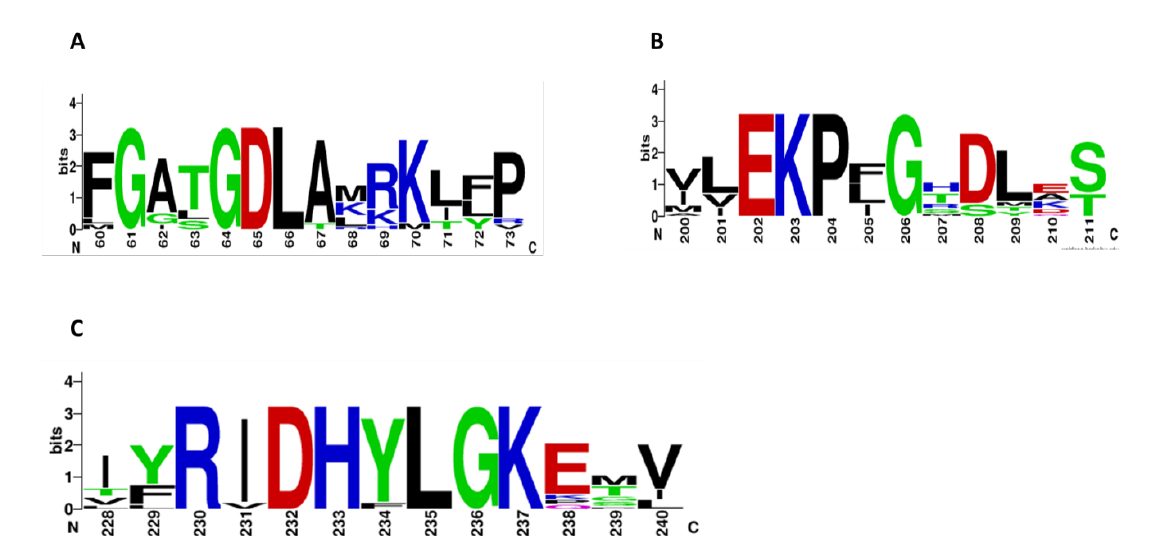
Figure 1. Multiple-sequence alignment of the G6PDs ’ amino acid sequences. Residues that have been reported to interact with the substrates ( A ) NADP + and ( B , C ) G6P are shown. The sequence alignment was carried out using the Uniprot UGENE software [27]. The comparison of conserved regions observed in the amino acid sequence alignment of G6PDs was conducted using the WebLogo3 online program.